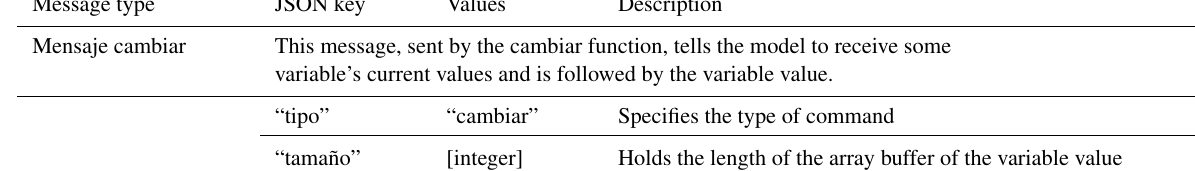
Table 1. Presentation of the generic JSON protocol. The context and order of these messages is more clearly illustrated in Fig. 1. Message type JSON